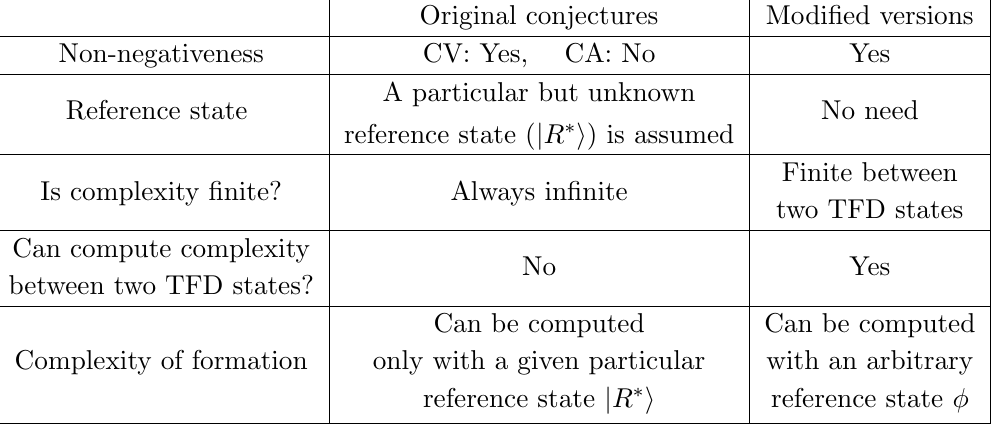
Table 1 . The di(cid:11)erences between the original CV and CA conjectures and our modi(cid:12)ed versions. The complexity of formation is de(cid:12)ned in ref. [29]. For a given reference state j (cid:30) i , the complexity of formation of state j 2 i from j 1 i is de(cid:12)ned by (cid:1) (cid:30) C ( j 2 i ; j 1 i ) := C ( j 2 i ; j (cid:30) i ) (cid:0) C ( j 1 i ; j (cid:30) i ).